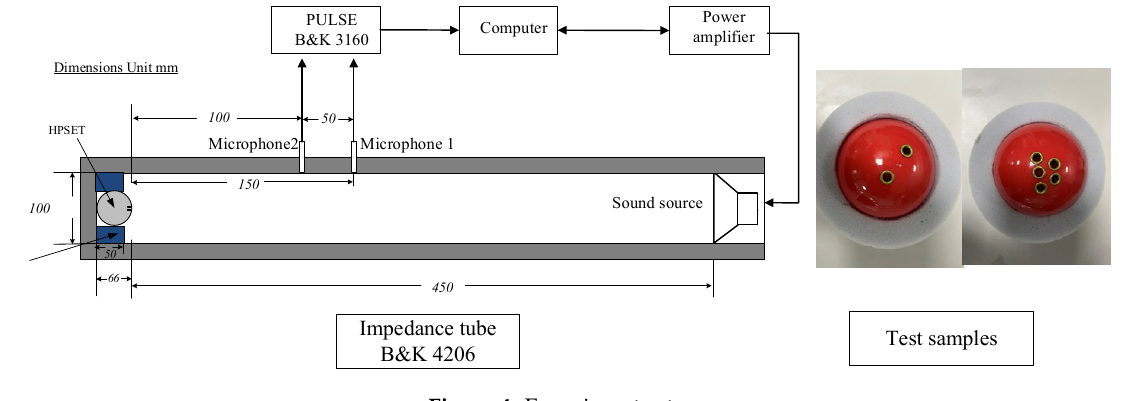
Figure 4. Experiment set up. Table 2. Parameters of the tested samples of HPSETs.